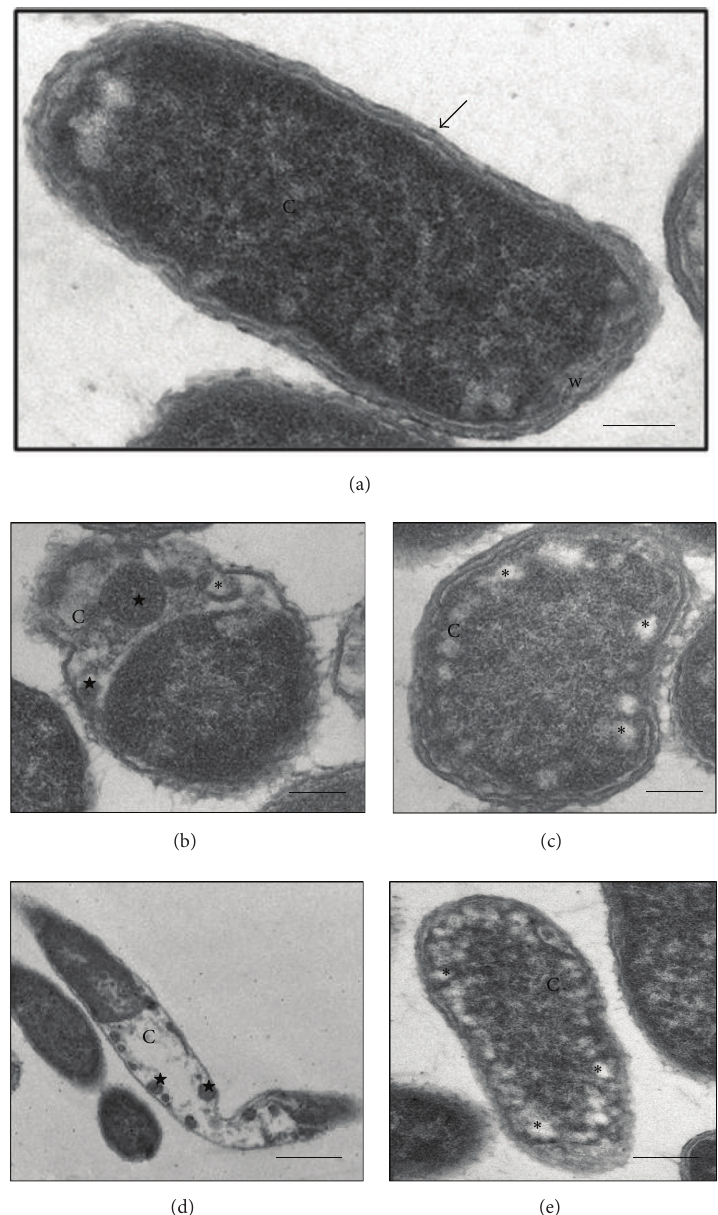
Figure 1: (a–e) Transmission electron micrographs of isolate K3C from K. pneumoniae . (a) bacterial cell without treatment (control)— preserved morphology, cytoplasmic membrane (arrow), cell wall (w), and cytoplasm (C) intact. (b-c) Cells subjected to CTX (64 𝜇 gmL −1 )— decreased cytoplasmic material (C), presence of membrane compartments (stars), electron-lucent spaces (asterisks) and disorganization of the membrane and cell wall. (d) Cell subjected to CAZ (32 𝜇 g mL −1 )—elongated aspect morphology with loss of cytoplasmic material (C) and the presence of small membrane compartments (stars). (e) Cell subjected to ATM (32 𝜇 g mL −1 )—normal morphology in the presence of electron-lucent spaces (asterisks) in the cytoplasm (C). Bars = 0.5 𝜇 m. CAZ: ceftazidime; CTX: cefotaxime; and ATM: